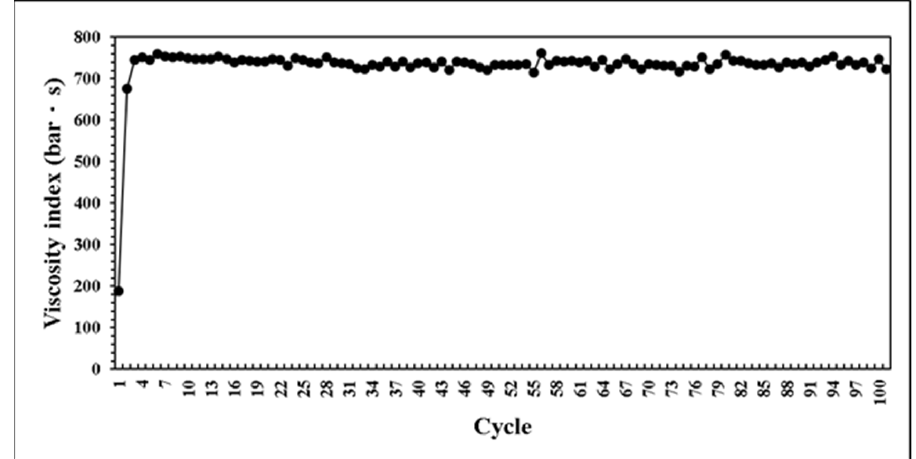
Figure 21. Distribution of viscosity index in experiment.